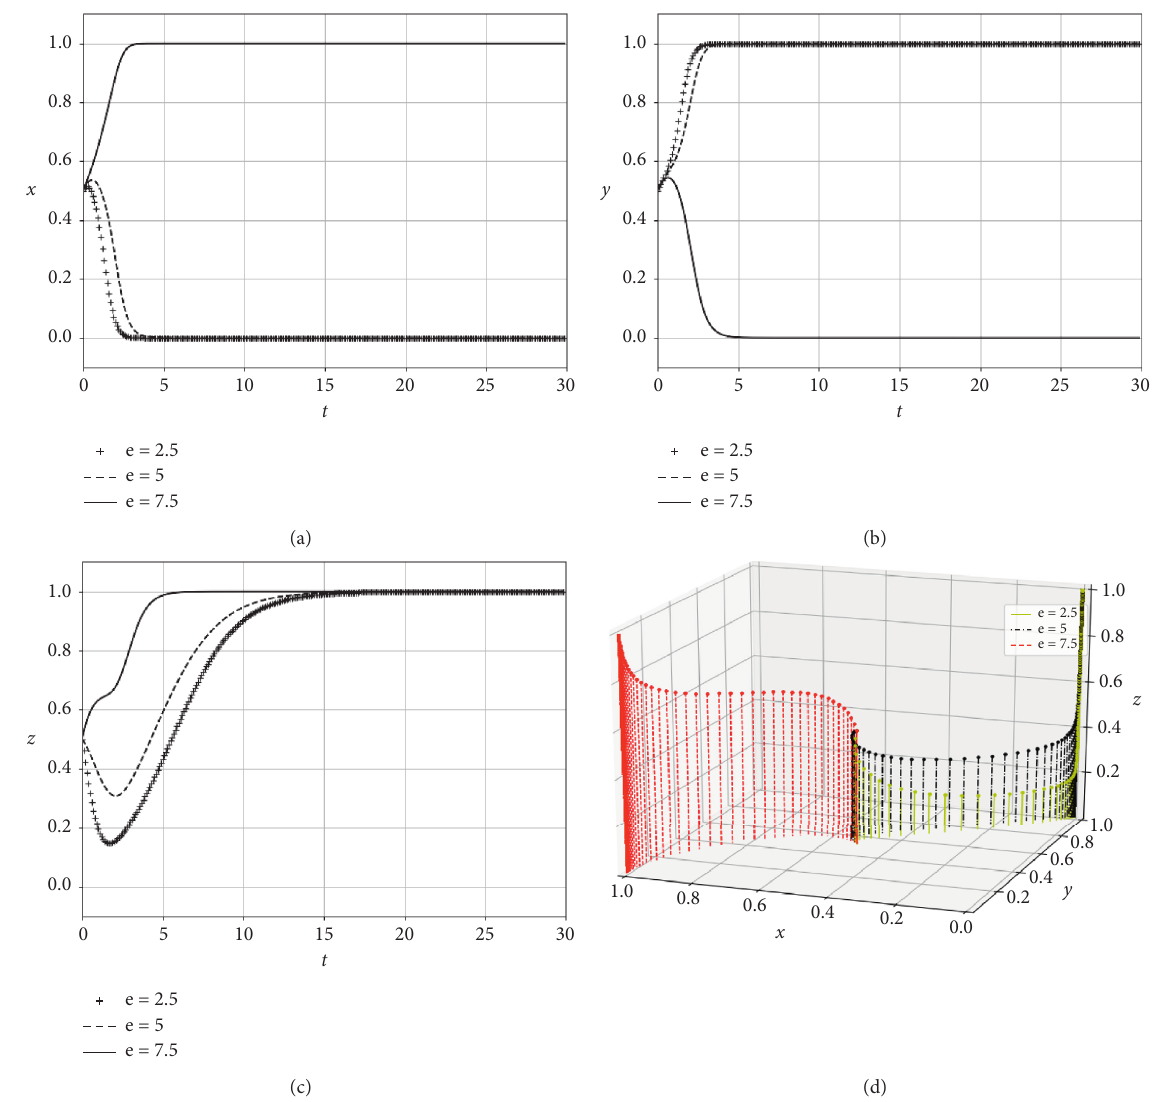
Figure 9: The evolution of the local government, the new media, and the local people, and the three parties with different resistance to the NIMBY facilities by local people when new media spread